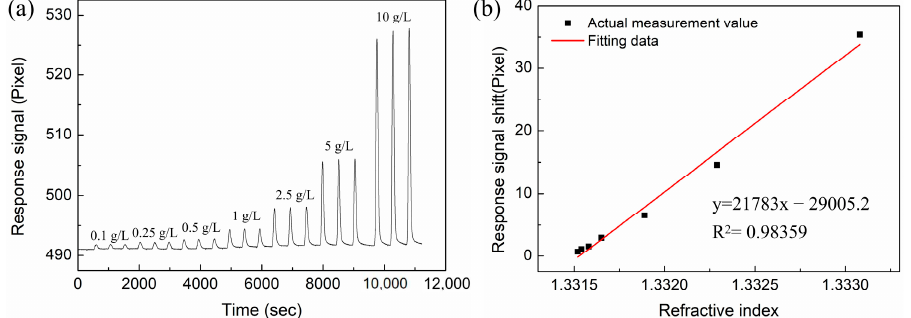
Figure 12. ( a ) The response curves of NaCl solution with different concentrations for the proposed